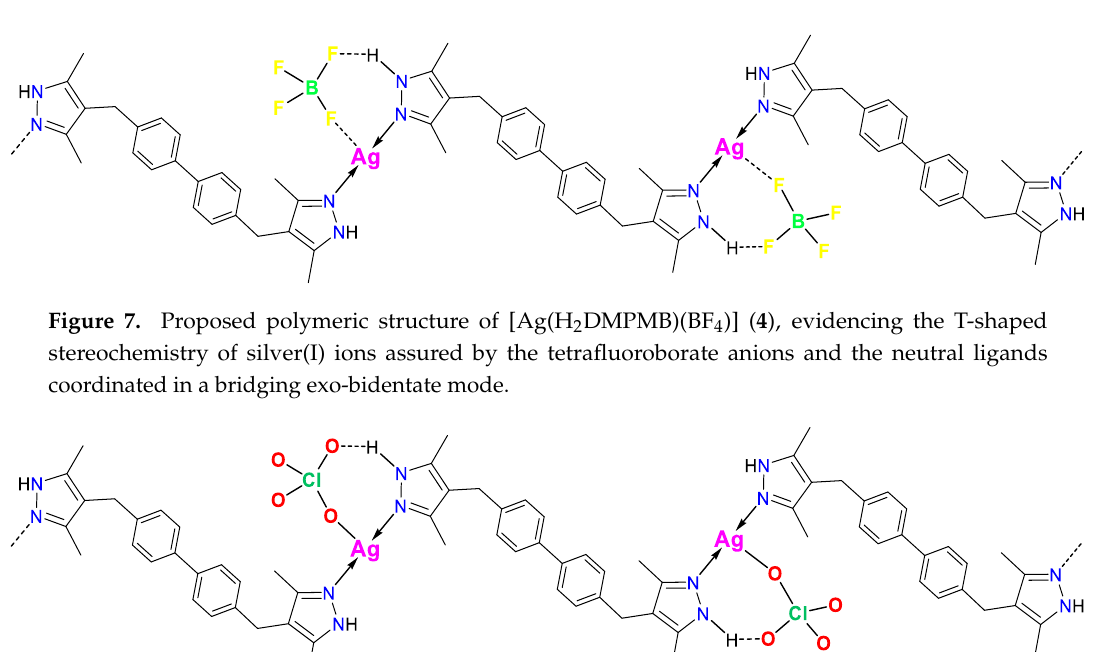
Figure 7. Proposed polymeric structure of [Ag(H 2 DMPMB)(BF 4 )] ( 4 ), evidencing the T-shaped stereochemistry of silver(I) ions assured by the tetrafluoroborate anions and the neutral ligands coordinated in a bridging exo-bidentate mode.